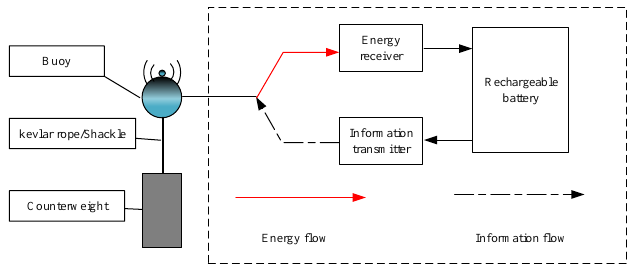
Figure 2. Components of the buoys in our proposed